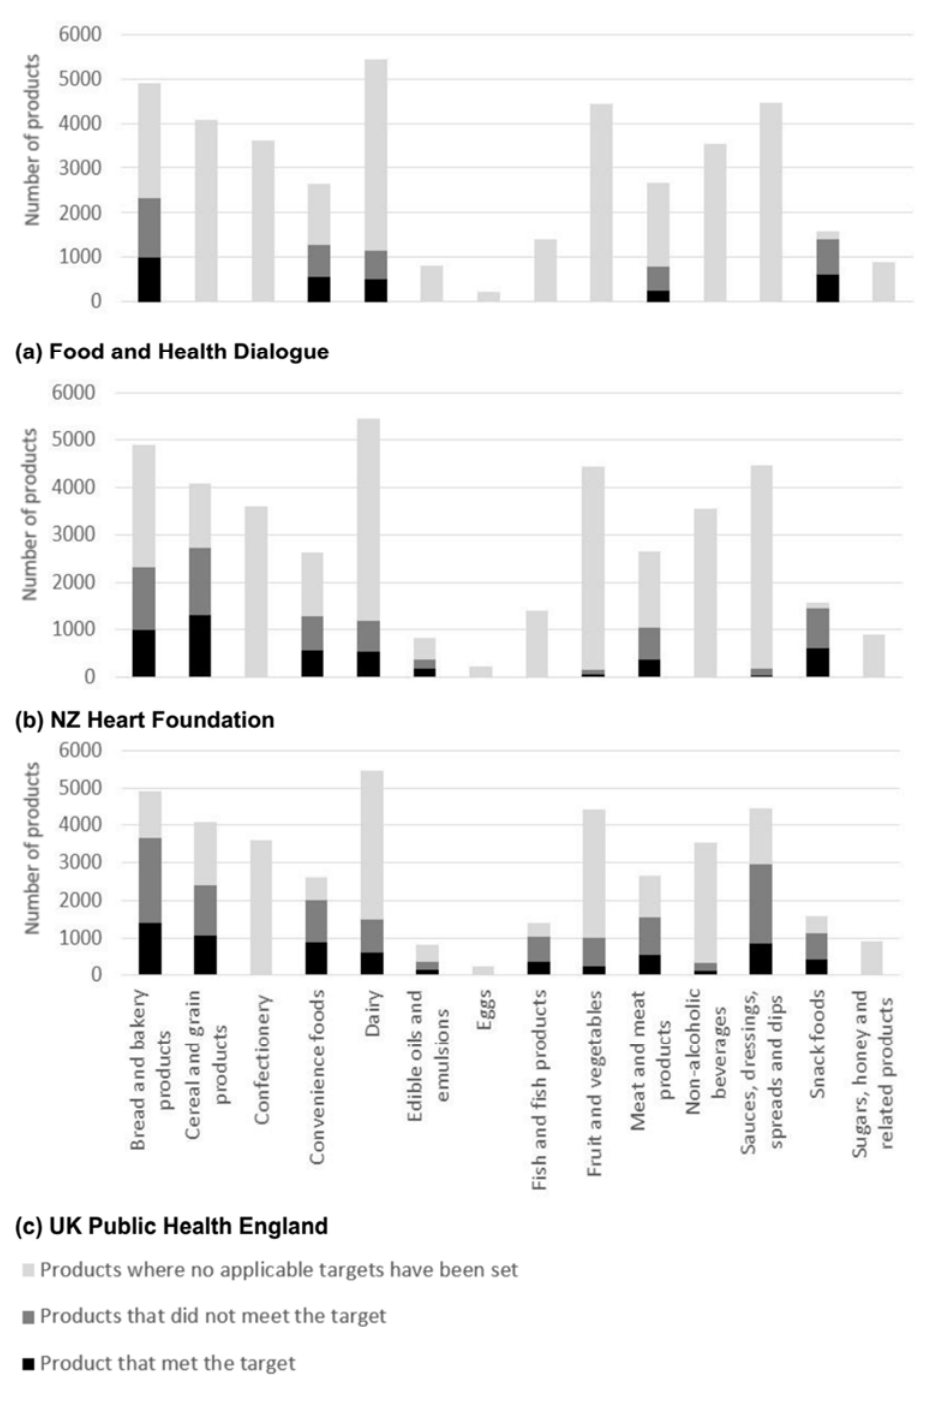
Figure 1. Number of Australian packaged food products without, with and meeting the sodium reformulation target set by either ( a ) Food and Health Dialogue [28]; ( b ) New Zealand Heart Foundation [31]; and/or ( c ) United Kingdom (UK) Public Health England *. * Where averages and maximum limits we both specified, maximum limits were used for analysis.